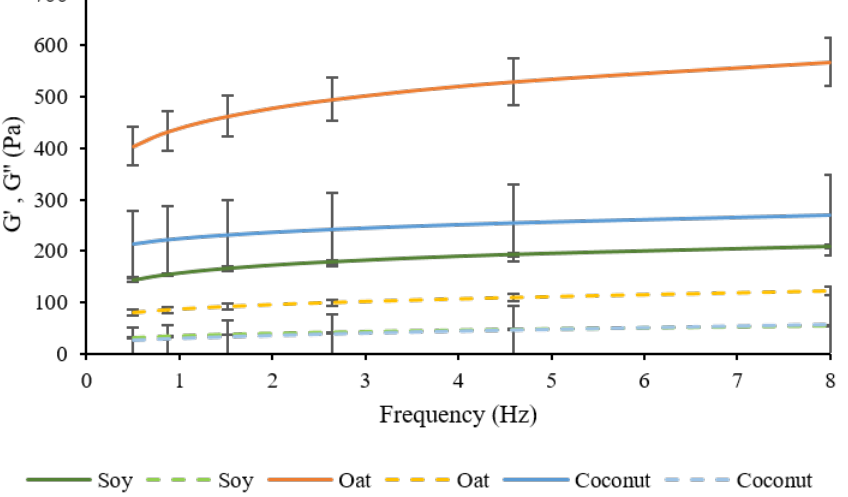
Figure 5. Dynamic mechanical spectra in frequency sweeps of fermented soy, oat, and coconut samples. Continuous lines correspond to G’, discontinuous lines correspond to